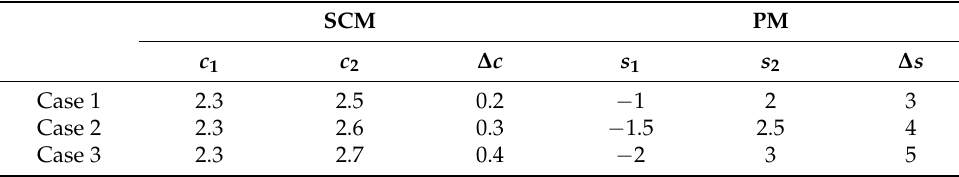
Table 1. Set of modulation parameters for experimental cases.